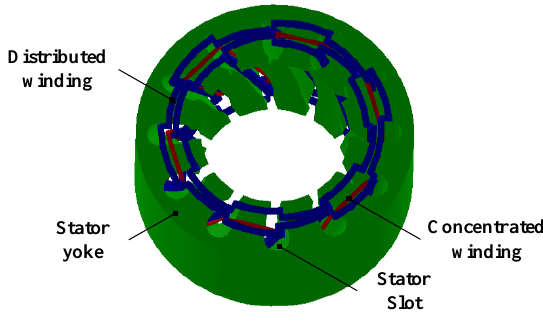
Figure 30. Three-dimensional model of the stator.